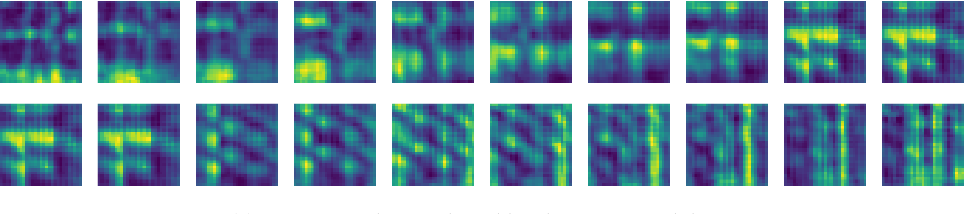
( c ) Some samples predicted by the CNN model. Figure 20. Some samples for walking motion: ( a ) predicted results of the FNO model, ( b ) target cross recurrence plot, and ( c ) predicted results of the CNN model.